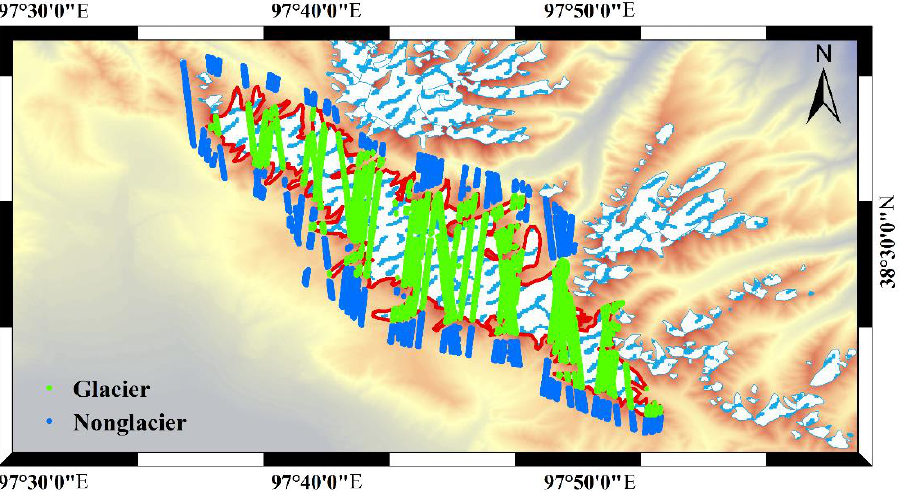
Figure 3. Schematic diagram of the registration data distribution. The blue and green points are the ICESat-2 data points located on nonglacial and glacial terrains, respectively.